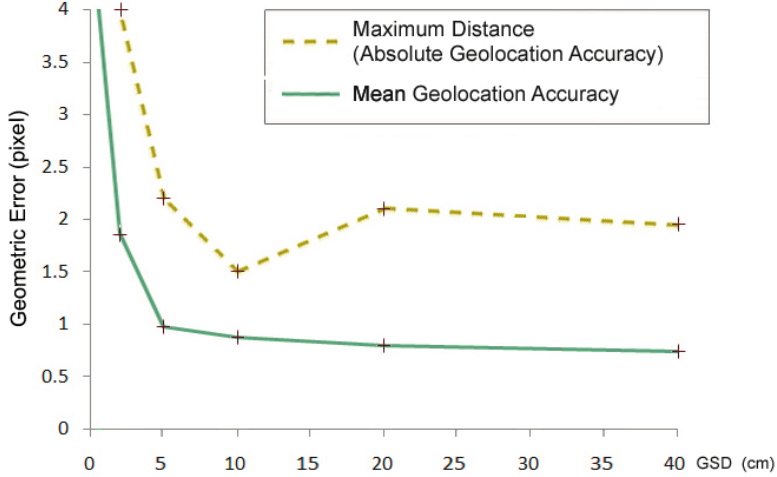
Figure 1. Relative geometric accuracy of different-resolution ortho image mosaics expressed in